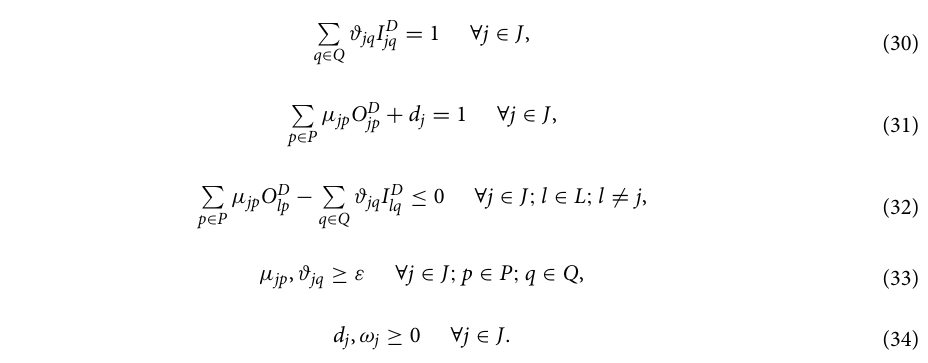
Figure 1. Solution evaluation criteria based on cost, service, and